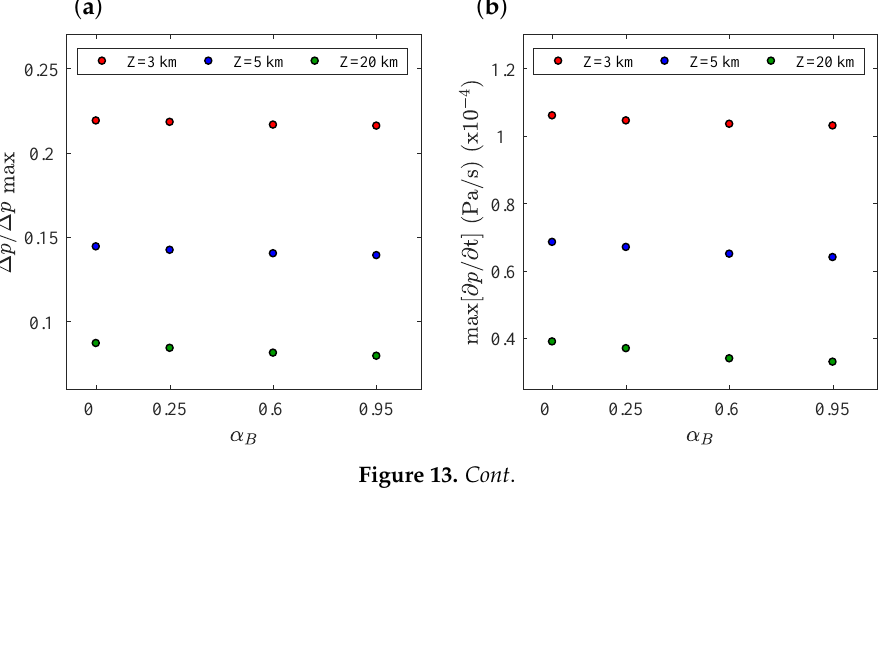
Figure 12. Effect of ∂ p/ ∂ t on the pore pressure diffusion. We plot the results for a reservoir with annual regulation in the left column, and for daily regulation in the right column. On panels ( a , b ), we represent the evolution of ∂ p/ ∂ t at 1, 3, 5, and 20 km depth. On panels ( c , d ), we depict ∂ p/ ∂ t on the fault when ∂ p/ ∂ t on the bed of the reservoir is maximum, i.e., the reservoir level is half. Table 3 lists the hydro-mechanical properties of the solid and the